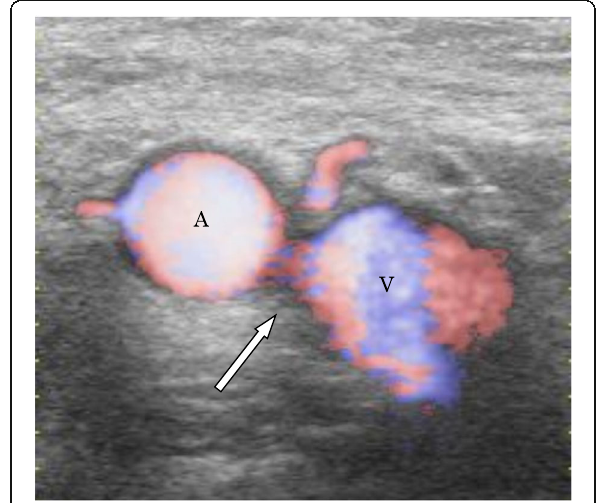
Fig. 2 Color Doppler ultrasound findings of an arteriovenous fistula between the right femoral artery and the right femoral vein. A femoral artery, V femoral vein, arrow